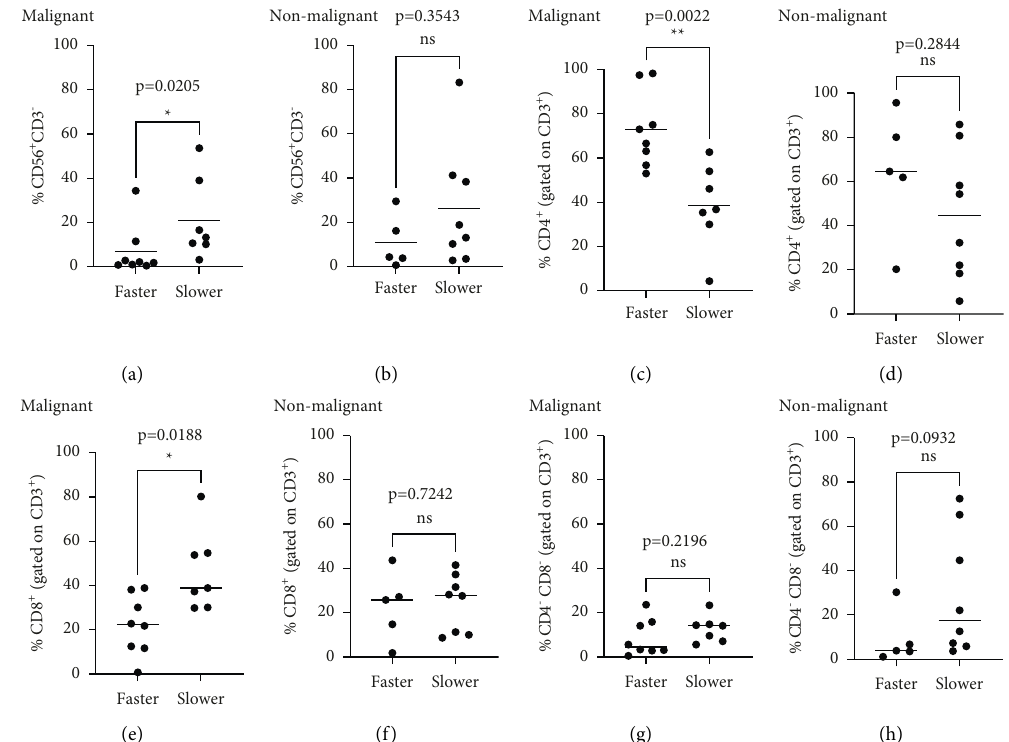
Figure 3: CD3 − CD56 + cells are associated with reduced TIL growth, whereas CD4 + T cells are preferentially found in faster-growing cultures. ILC (CD3 − CD56 + ) (a, b), CD4 + (c, d), CD8 + (e, f), and CD4 − CD8 − (g, h) subsets were quantified in TIL cultures according to their rates of expansion (faster or slower). Analysis was performed for malignant and nonmalignant TIL cultures as indicated. Two-tailed Mann- Whitney tests were used for A-H.